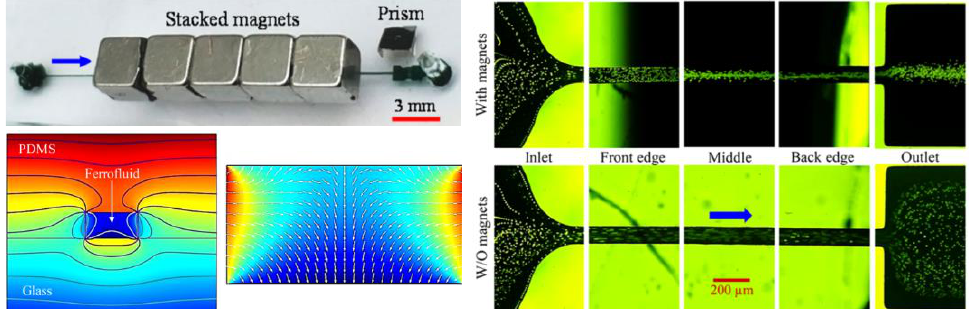
Figure 7. Sheath-free diamagnetic particle focusing in the flow of ferrofluids under the magnetic field of a single magnet: Picture of the microfluidic chip with 5 stacked permanent magnets right above (upper left); Simulated magnetic field contour and magnetic force in the cross-section the device (lower left); Experimental images of 10 μm diamagnetic beads in the 0.75 mL/h flow of 0.75× EMG 408 ferrofluid through a straight rectangular microchannel with and without the magnets (right). Adapted with permission from Chen et al. [97], 2018 American Chemical Society.